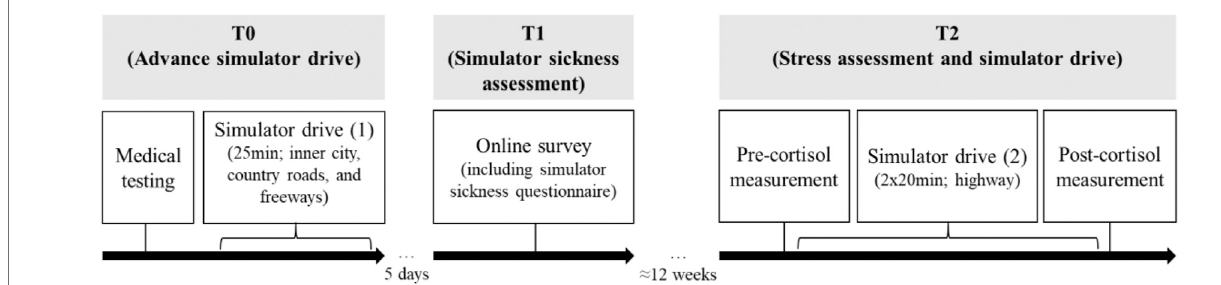
FIGURE 2 | Visualization of the experimental setup.